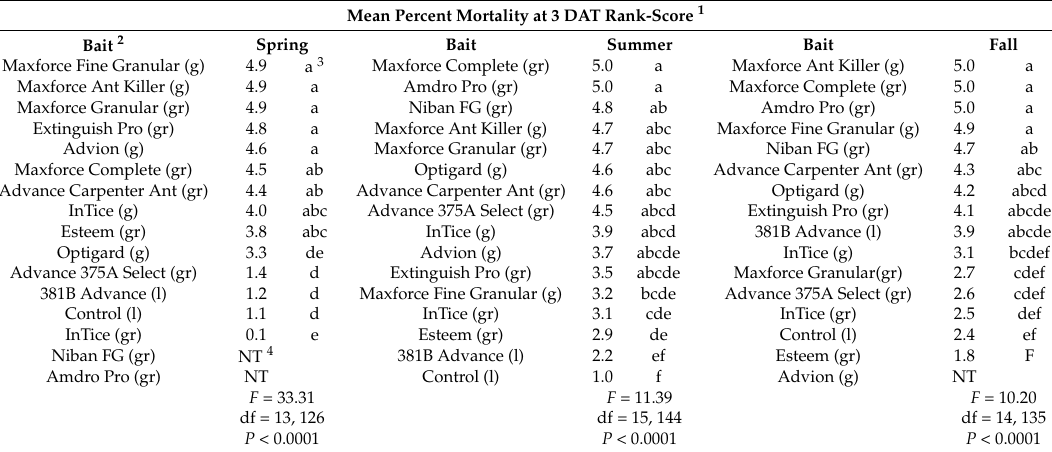
Table 5. Mean percent mortality rank-score of Nylanderia fulva at 3 days after continuous exposure to 15 commercially available baits in no-choice laboratory assays over three seasons (2009–2010) (n = 10 replications for each bait per